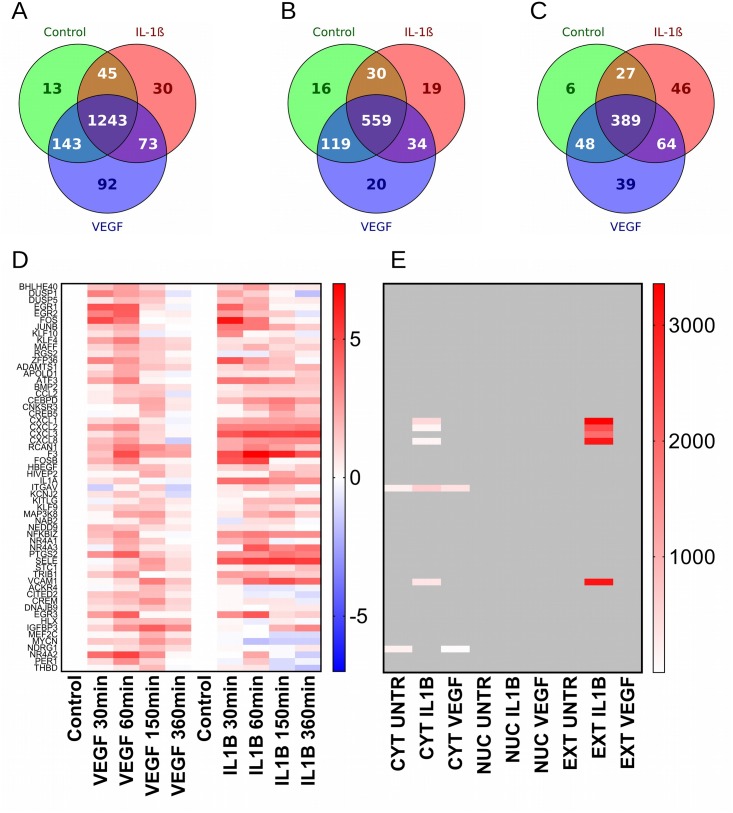
Venn diagrams and heat maps of the proteins detected HUVEC.Venn diagrams are displayed for untreated HUVEC (green circles), HUVEC treated with 10ng/mL IL-1β (red circles) and HUVEC treated with 10ng/mL VEGF (blue circles). (A) cytoplasm fraction, (B) nucleic fraction, (C) extracellular fraction, (D) reanalysis of E-GEOD-10778 (IL-1β and VEGF stimulated HUVEC, mRNA of genes regulated by IL-1β or VEGF stimulation, red = upregulated, blue = downregulated) and (E) corresponding protein expression (red = expression level, grey = not detected).